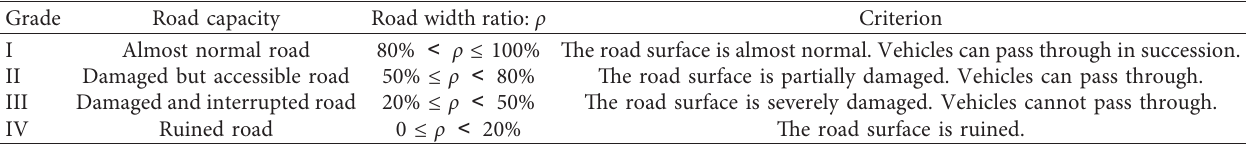
Table 3: Postearthquake road capacity scheme.